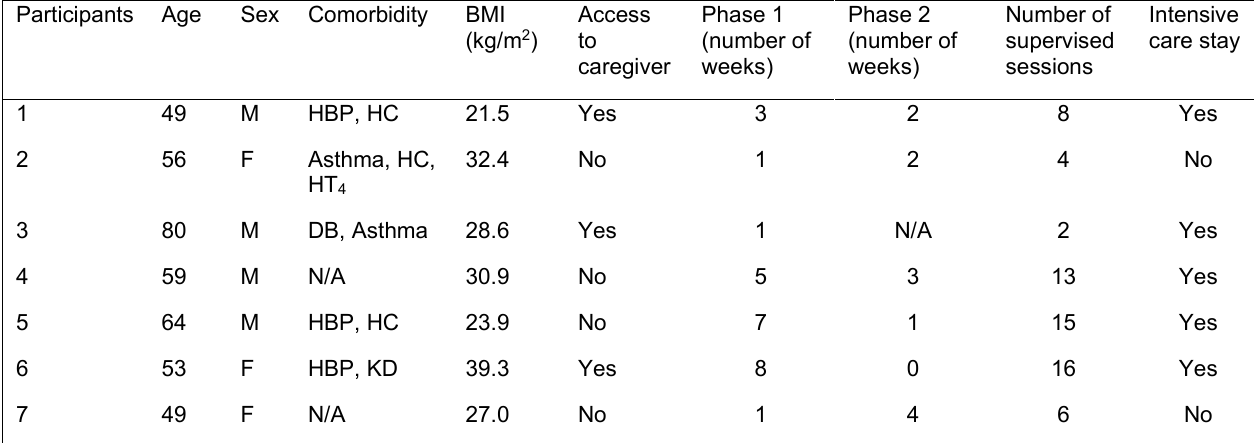
Characteristics of